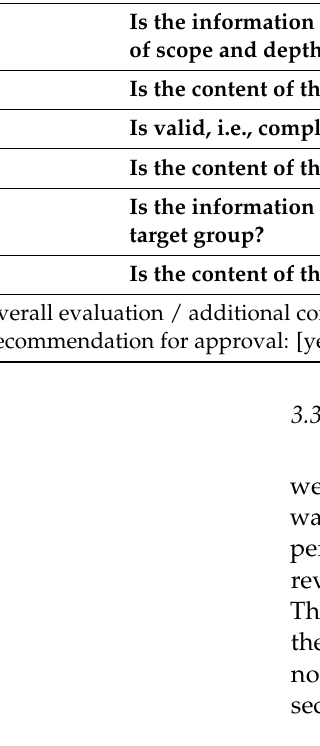
Table 4. Results of the pilot validation using “Therapie-App” and “Sprunggelenks-App”. Sub-criteria were rated as fulfilled (green), not fulfilled (red) or not assessable